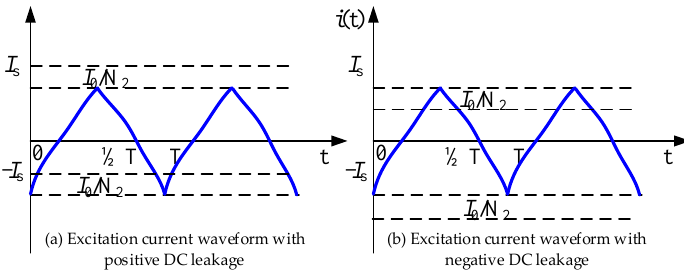
Figure 7. Excitation current waveform with DC leakage.